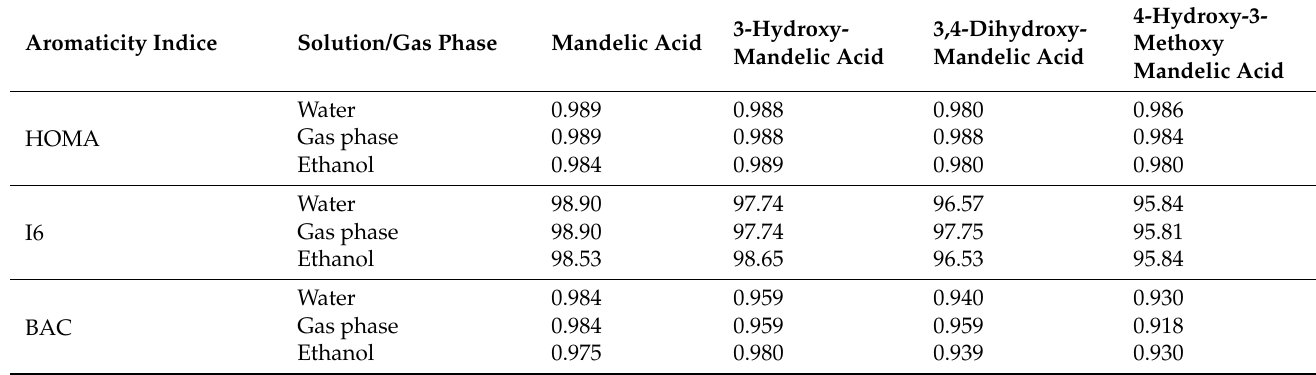
Table 3. Aromaticity indices (HOMA, Bird’s indices (I6) and BAC) for mandelic acid and its deriva- tives for gas phase, water and ethanolic